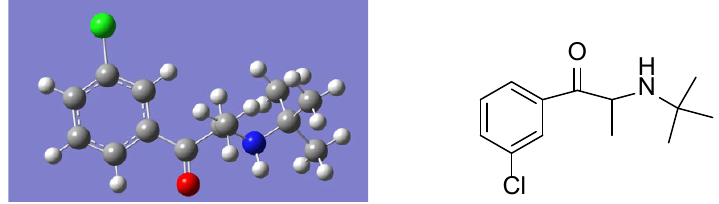
Fig. 1. Optimized structure of Bupropion by B3LYP/6-311+G(d, Fig 1. Optimized structure of Bupropion by B3LYP/6-311+G(d, p)